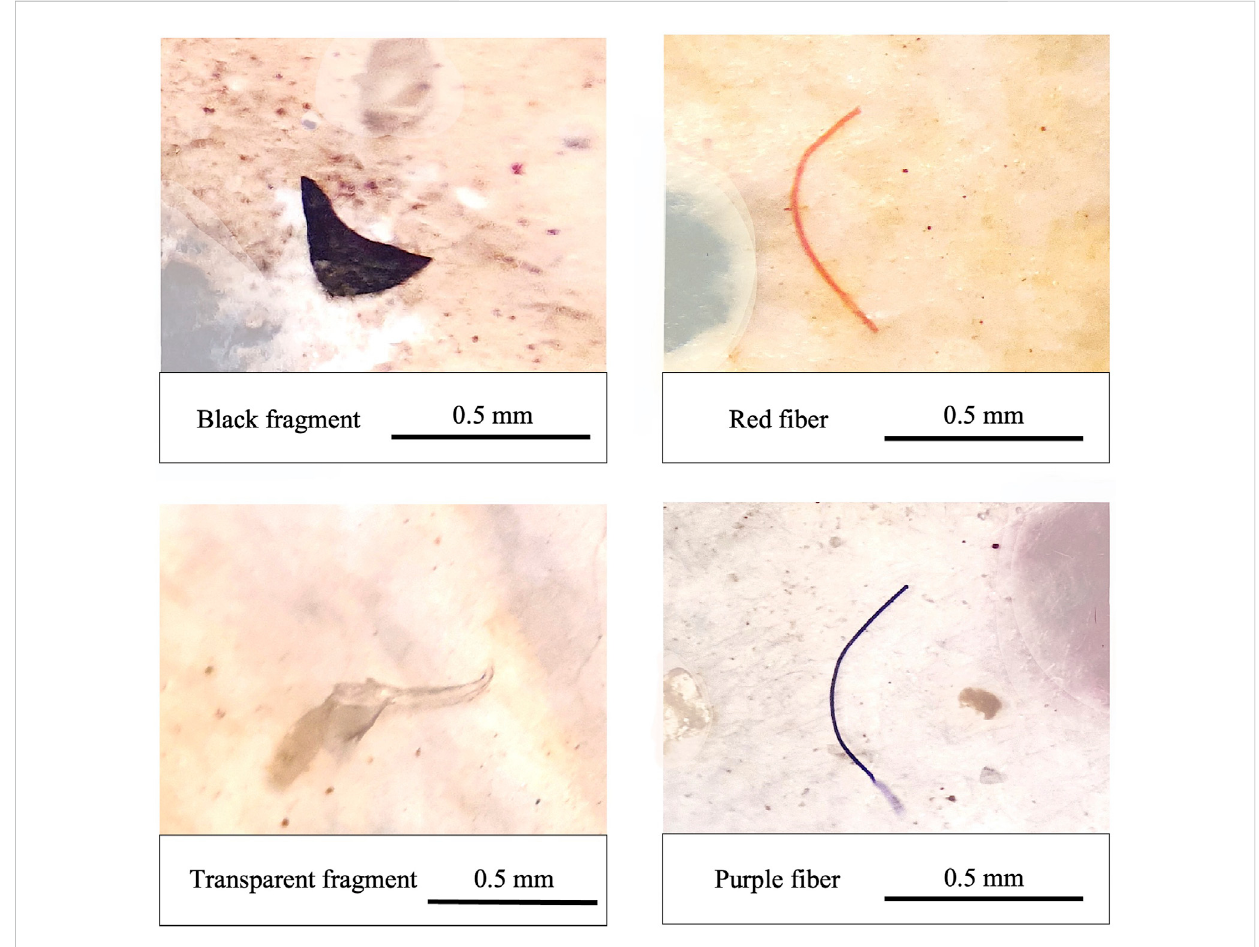
FIGURE 4 Examples of microplastics found in this study (from the top left in the clockwise direction): black fragment, red fi ber, purple fi ber, and transparent fi ber.